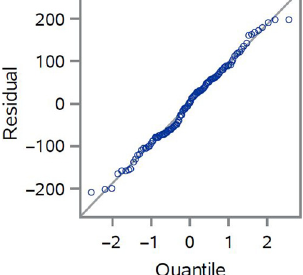
Figure 4. ACC Cann regression fi t plot